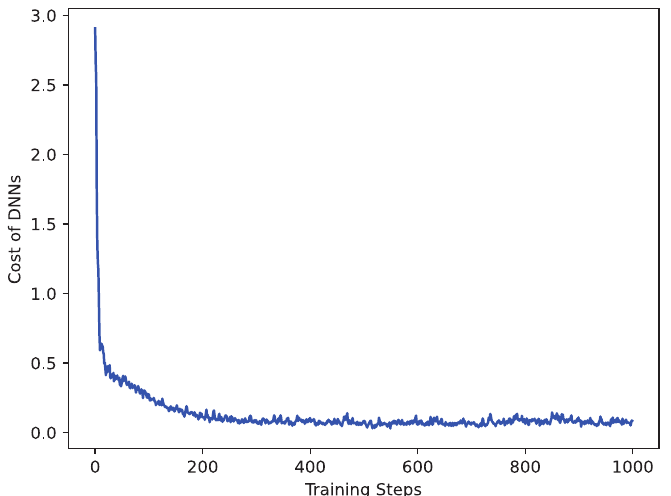
Figure 3. The cost of DNNs against training steps.